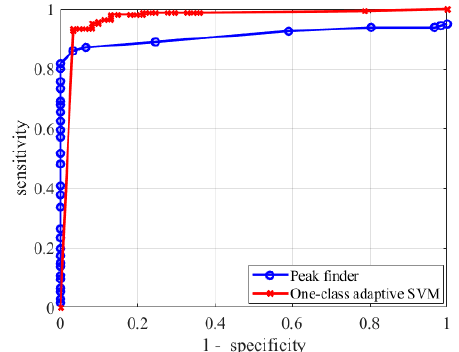
Figure 7. Receiver Operating Characteristic (ROC) curves of the peak finder algorithms and the new One-class adaptive support-vector machine